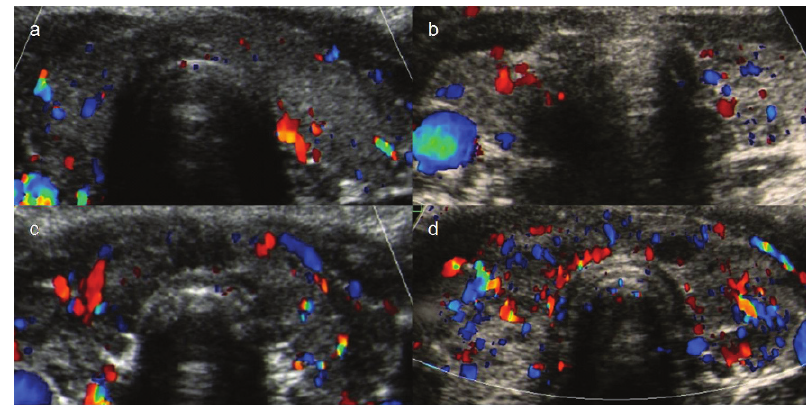
Figure 2 - Color Doppler patterns. a. Pattern 0 (normal thyroid vascularity); b. color Doppler Pattern I (minimally increased thyroid vascularity); c. color Doppler Pattern II (increased blood flow with a diffuse homogenous distribution); and d. color Doppler Pattern III (‘‘thyroid